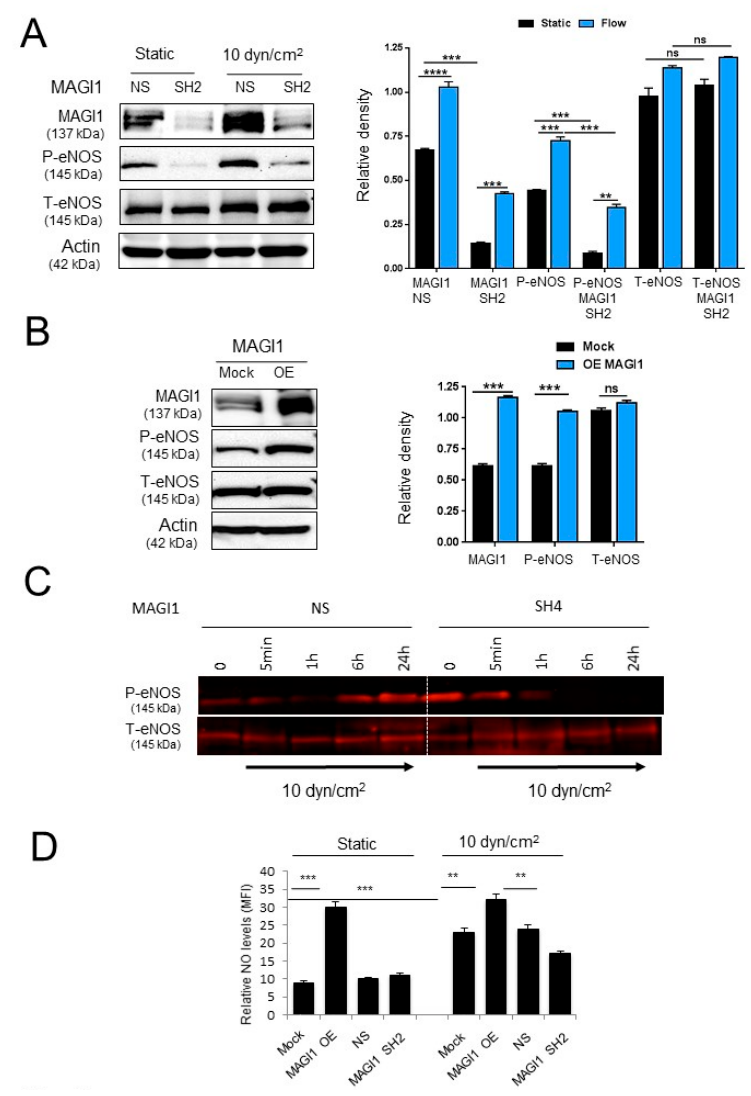
Figure 3. MAGI1 promotes eNOS phosphorylation. ( A ) Control (NS) and MAGI1-silenced (SH) HUVEC under static or flow (10 dyn / cm 2 , OS) conditions for 24 h were analysed by Western blotting for eNOS Ser 1177 phosphorylation, total eNOS and MAGI1. No. of repetitions = 2. ( B ) Western blotting analysis of eNOS Ser 1177 phosphorylation total eNOS and MAGI1 in control (Mock) and MAGI1-overexpressing (OE) HUVEC under static conditions. MAGI is required for and mediates eNOS phosphorylation. N = 3. Beta actin is shown as loading control. Relative band quantifications by densitometry of multiple experiments are shown next to the blots. ( C ) Non-silenced (NS) or MAGI1 silenced (SH4) HUVEC were cultured under static conditions (0) or exposed to 10 dyn / cm 2 fluid shear stress in the orbital shaker (OS) systems for the indicated time and analysed for phosphorylated (Ser1177) and total eNOS levels by Western blotting. MAGI silencing reduces sustained flow-induced eNOS phosphorylation. ( D ) Control HUVEC (Mock and NS), HUVEC with silenced (SH) or overexpressed MAGI1 (OE) under static of flow (10 dyn / cm 2 , 24 h) conditions were monitored for NO production. N = 3, triplicate conditions each. ** p < 0.01; *** p < 0.001; ns, non-significant. These results indicated that MAGI1 mediates shear stress-induced sustained eNOS activation and NO